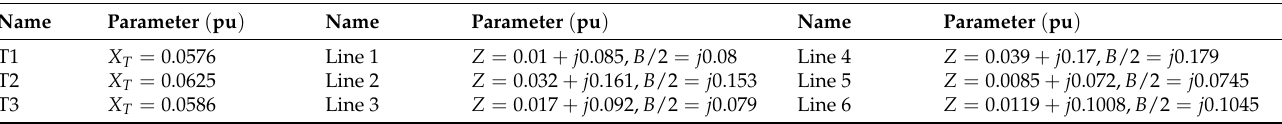
Table A3. Parameters of transformers and lines in the WSCC 9-bus